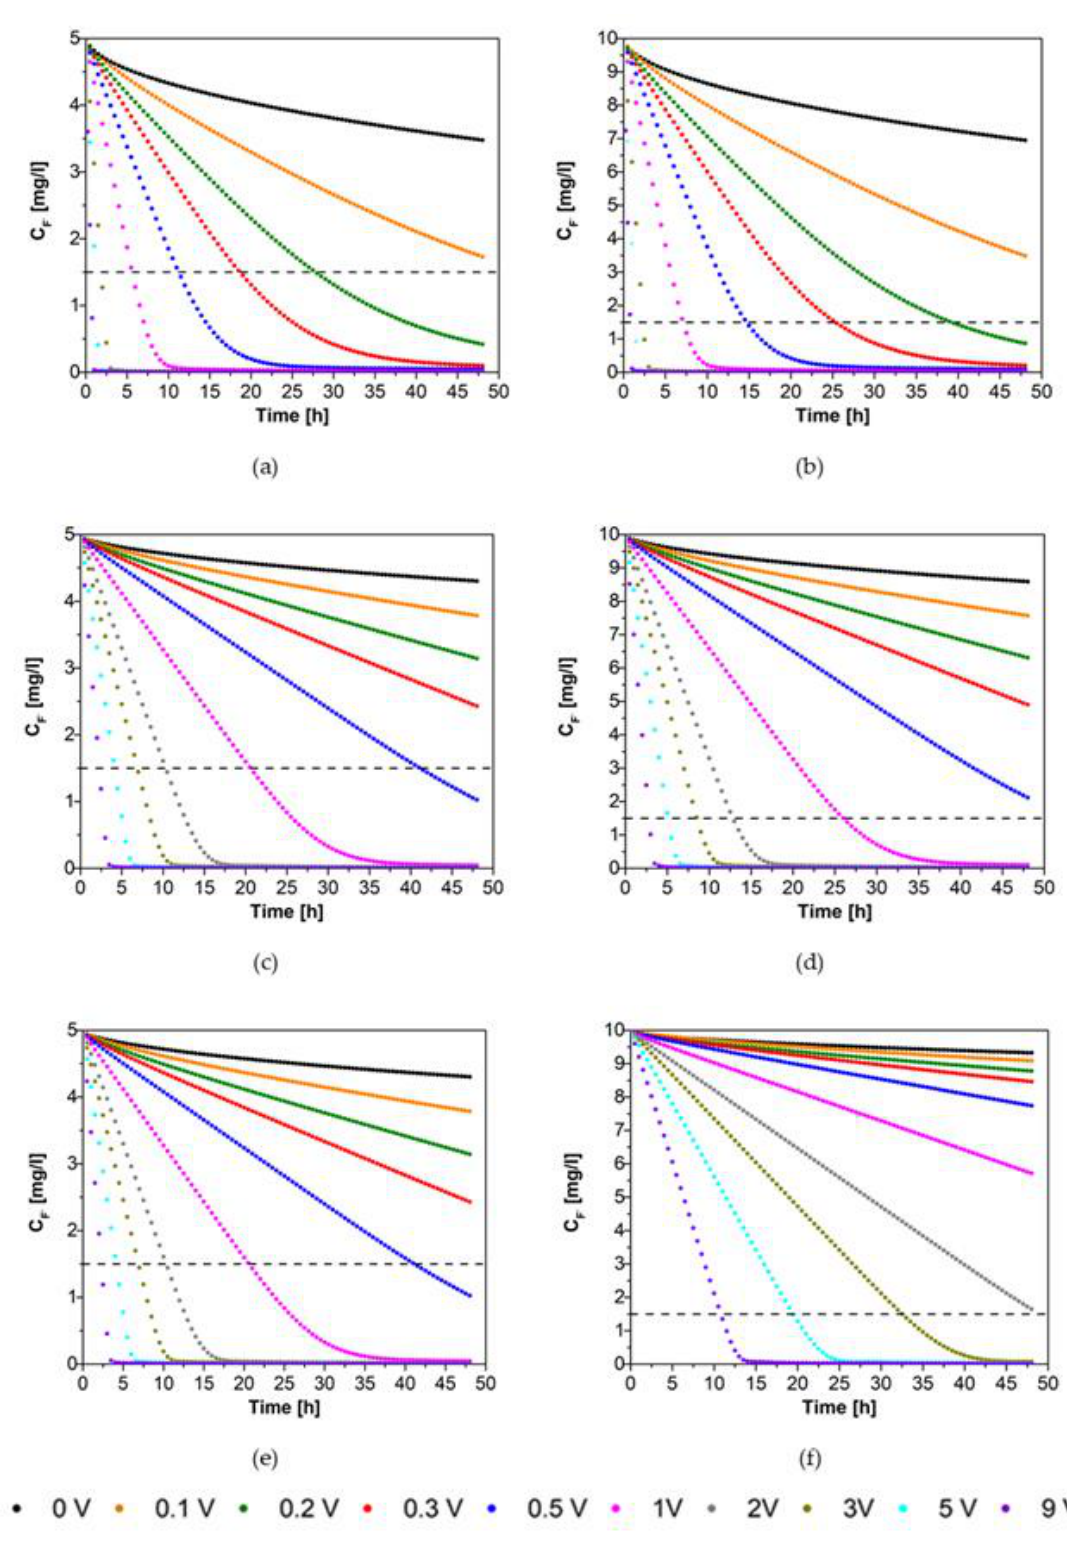
Figure 3. Fluoride concentration in water as a function of time and applied voltage V 0 for ( a ) w w = 5 cm, c n 0 = 5 mg/L; ( b ) w w = 5 cm, c n 0 = 10 mg/L; ( c ) w w = 10 cm, c n 0 = 5 mg/L; ( d ) w w = 10 cm, c n 0 = 10 mg/L; ( e ) w w = 20 cm, c n 0 = 5 mg/L; and ( f ) w w = 20 cm; c n 0 = 10 mg/L. The dashed line indicates the F − threshold value discussed